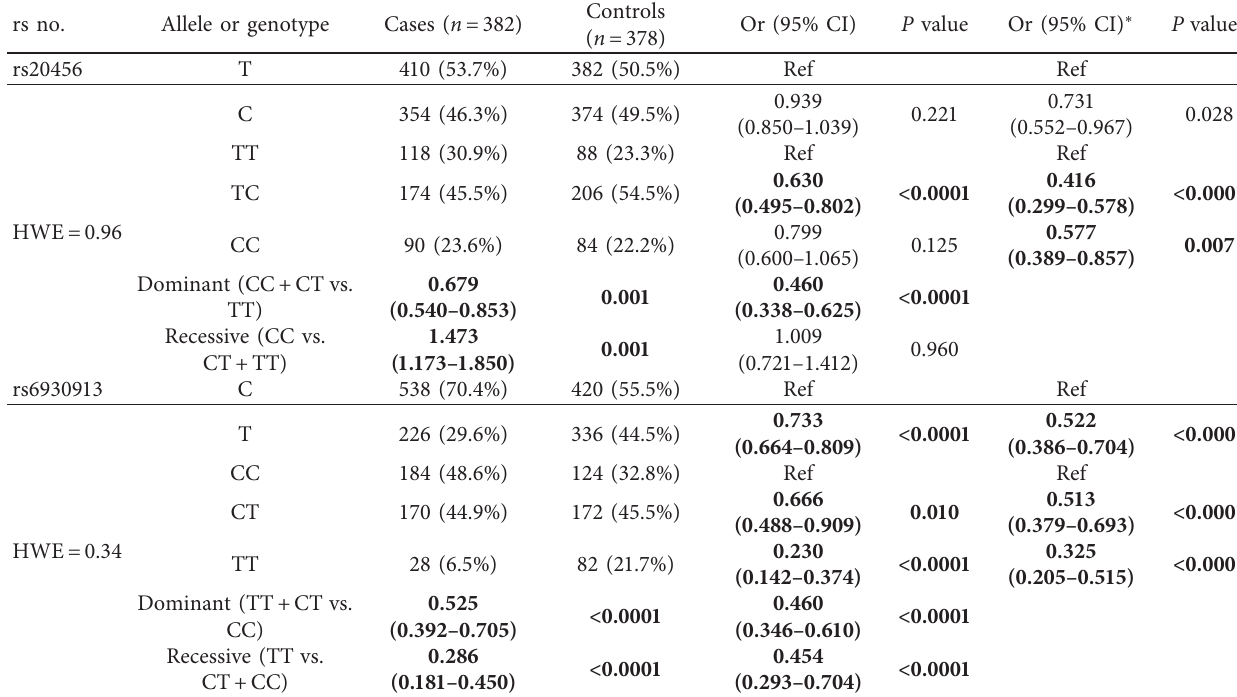
Table 3: Association of KIF6 gene polymorphisms with hypertension